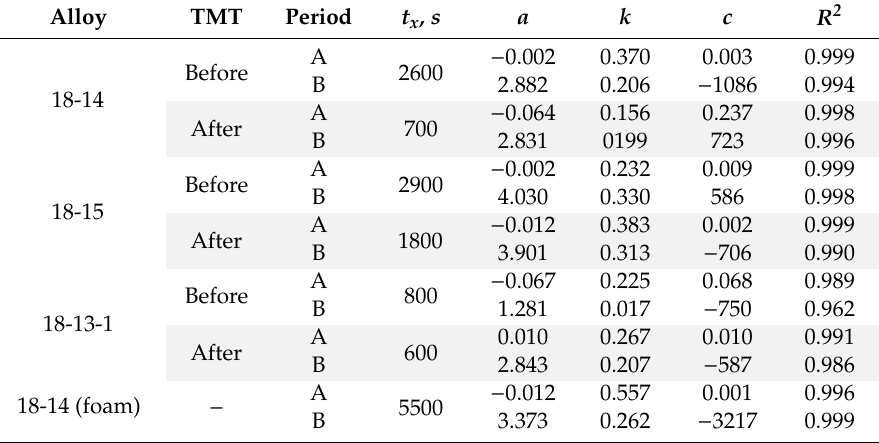
Table 10. The results of OCP curves approximation for the 18-14, 18-15, and 18-13-1 alloys before and after TMT, and the 18-14-based foam material in Hanks’ solution at 310 K.